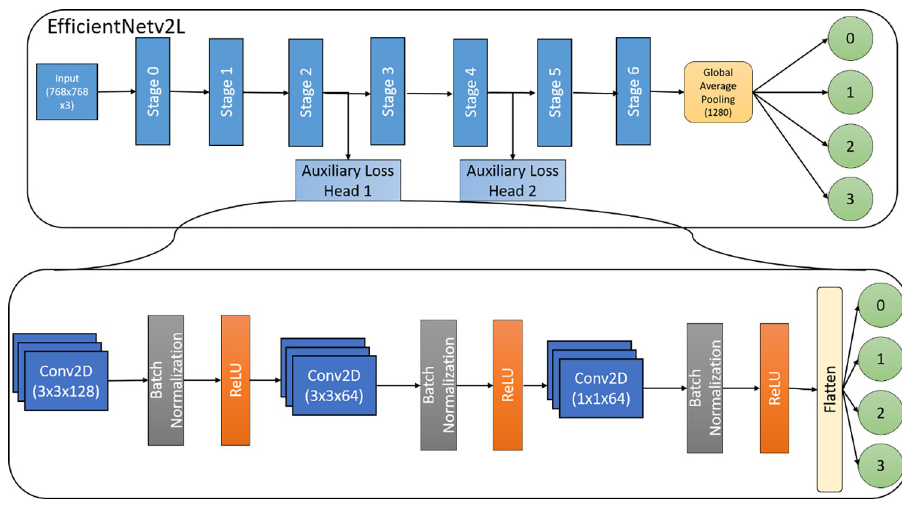
Fig 6. Proposed neural network